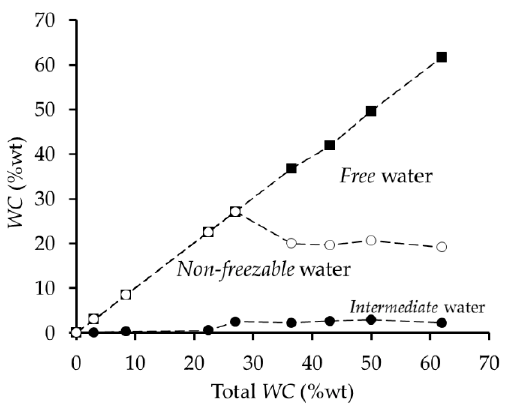
Figure 20. Water states distribution in PVA at different WC . ( • ) Intermediate water; (o) non-freezable water; ( ▪ ) free water. Data obtained from [70].